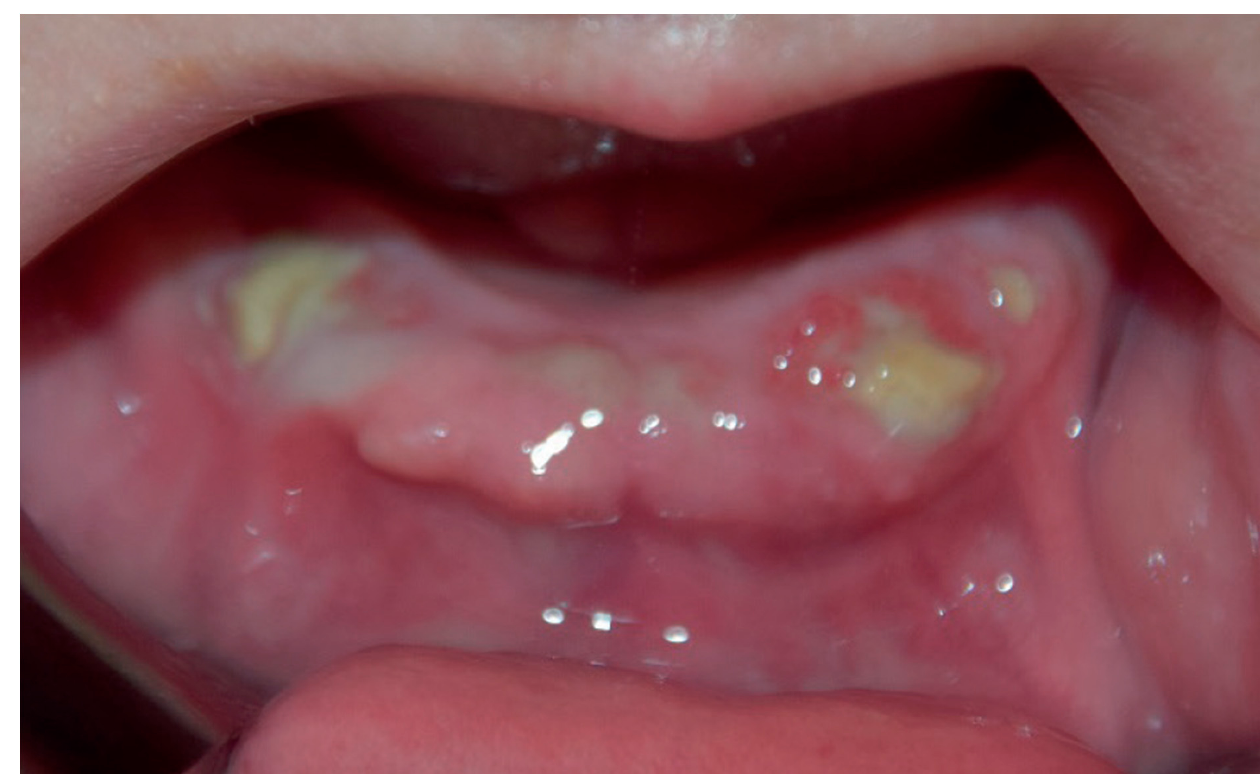
Figure 1. Intraoral image. The exposed bone of the alveolar part of the mandible.